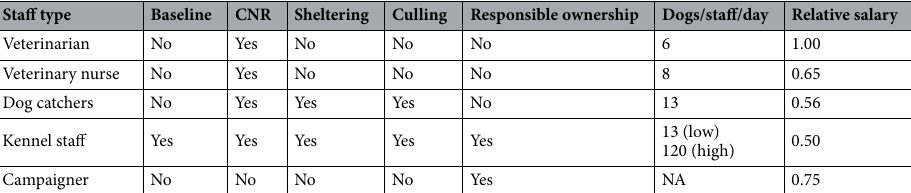
Using the projected population sizes, the staff time required for each staff type (e.g. number of veterinarian- months of work required) was calculated for each intervention. Relative salaries for the different staff types were estimated (Table 3). The relative salaries were used to calculate the cost of the interventions by: [Staff time required × relative salary ] × €20,000. Where €20,000 was the estimated annual salary of a European veterinarian, allowing relative staff-time costs to be compared between the different interventions. Average annual costs were reported. To provide overall welfare scores for each of the interventions, we apply the estimated welfare scores on a one to five scale, for each of the dog subpopulations, as determined by Hogasen et al. (2013) 22 . This scale is based on the Five Freedoms (freedom from hunger and thirst; freedom from discomfort; freedom from pain, injury, or disease; freedom to express normal behaviour; freedom from fear and distress 42,43 ) and was calculated using expert opinions from 60 veterinarians in Italy 22 . The scores were weighted by the participants’ self-reported knowledge of different dog subpopulations, which resulted in the following scores: 2.8 for shelter dogs (W H ); 3.5 for owned dogs (W O ); 3.1 for neutered free-roaming dogs (W N ); and 2.3 for intact free-roaming dogs (W I ) 22 . Using these estimated welfare scores, we calculated an average welfare score for the total dog population based on the model’s projected population sizes for each subpopulation (Eq. 10). For interventions running for the duration of the simulation, the welfare score was calculated at the time point ( t ) when the population reached an equilibrium size. For interventions running for five years, the welfare score was calculated at the end of the five-year intervention. The percentage change in welfare scores from the baseline simulation were reported.